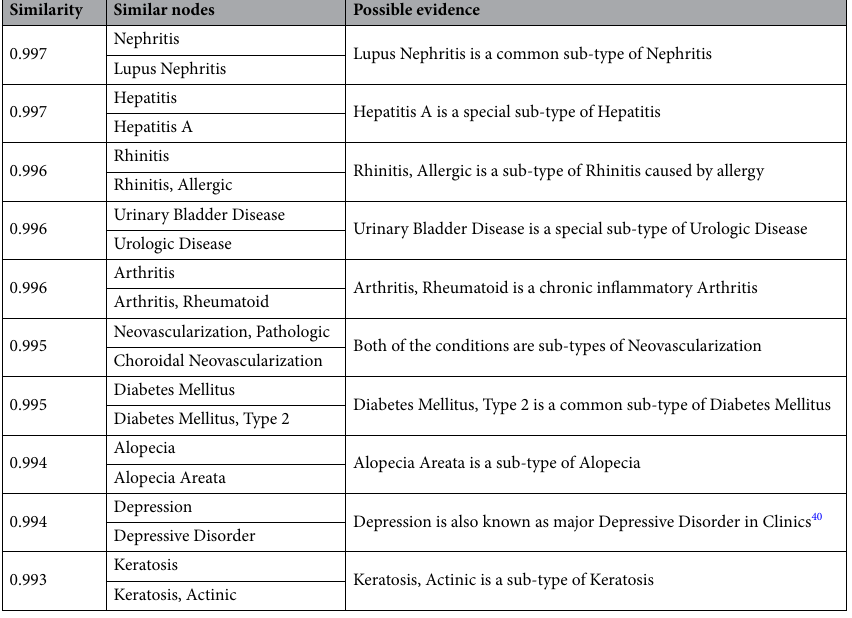
Table 5. Top-10 most similar condition nodes. The average cosine similarity among condition nodes is 0.311.